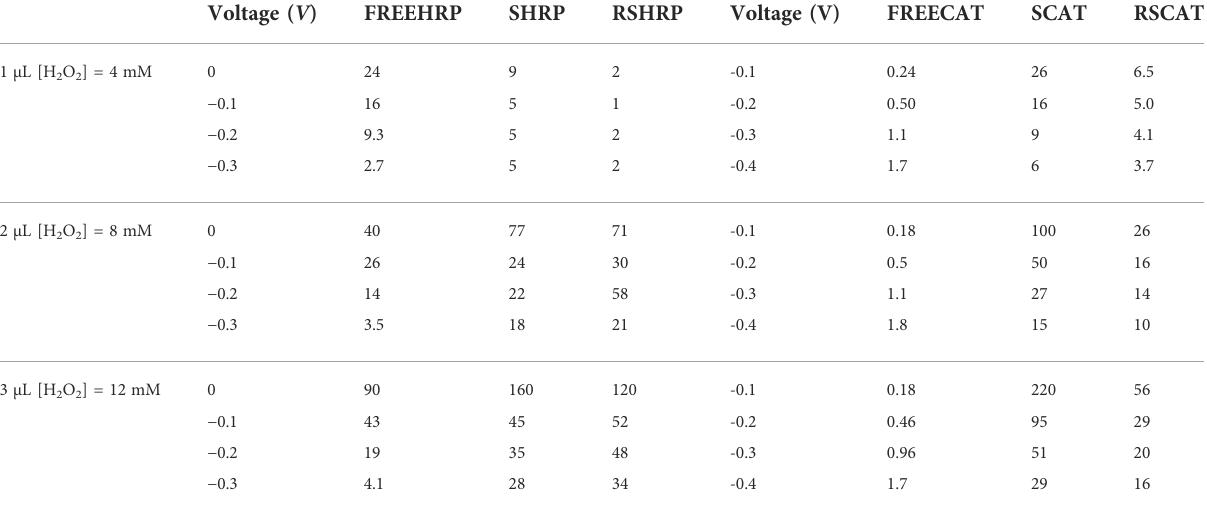
TABLE 2 Signal-to-Noise values for amperometric